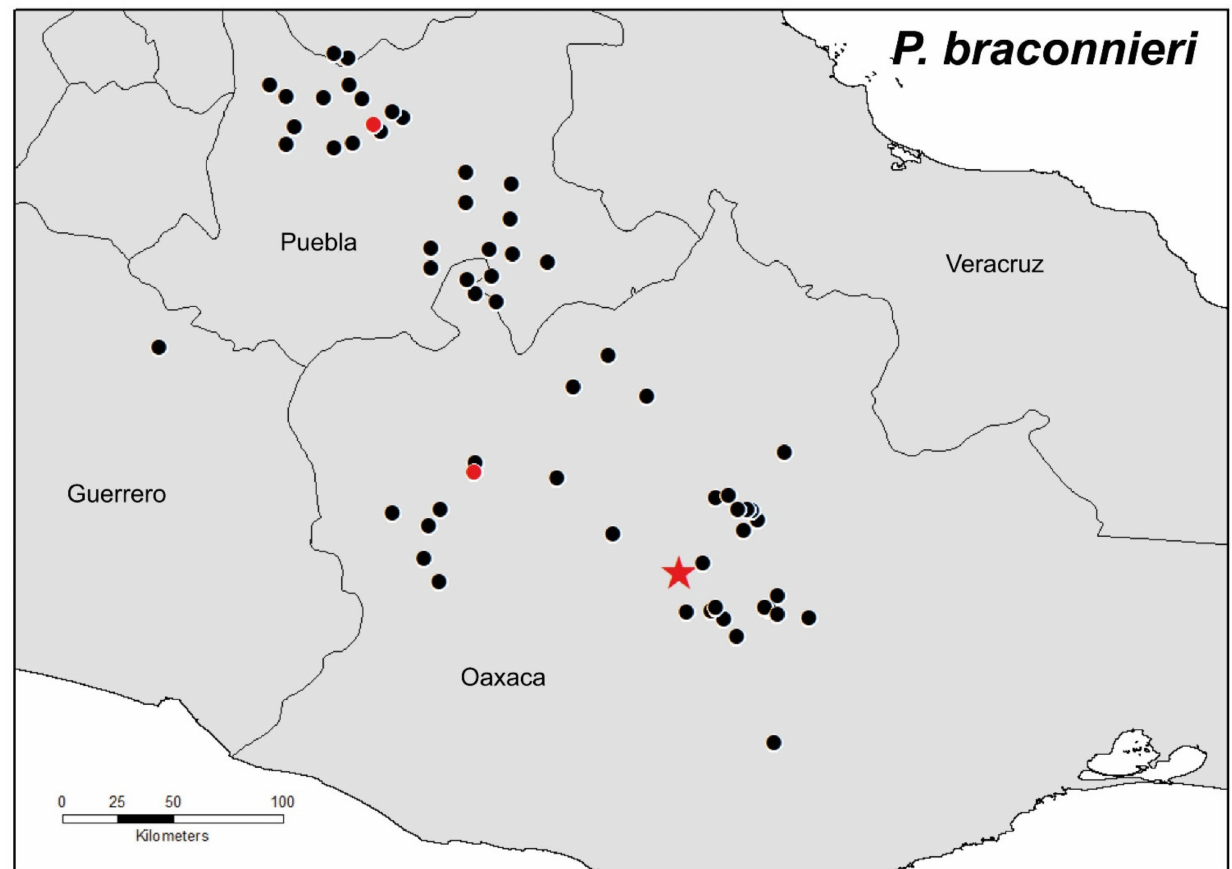
Figure 7. Map showing distributional records of Phrynosoma braconnieri . Red circles = genetically confirmed records; black circles = records that have not been genetically confirmed; red star = type locality of P. braconnieri